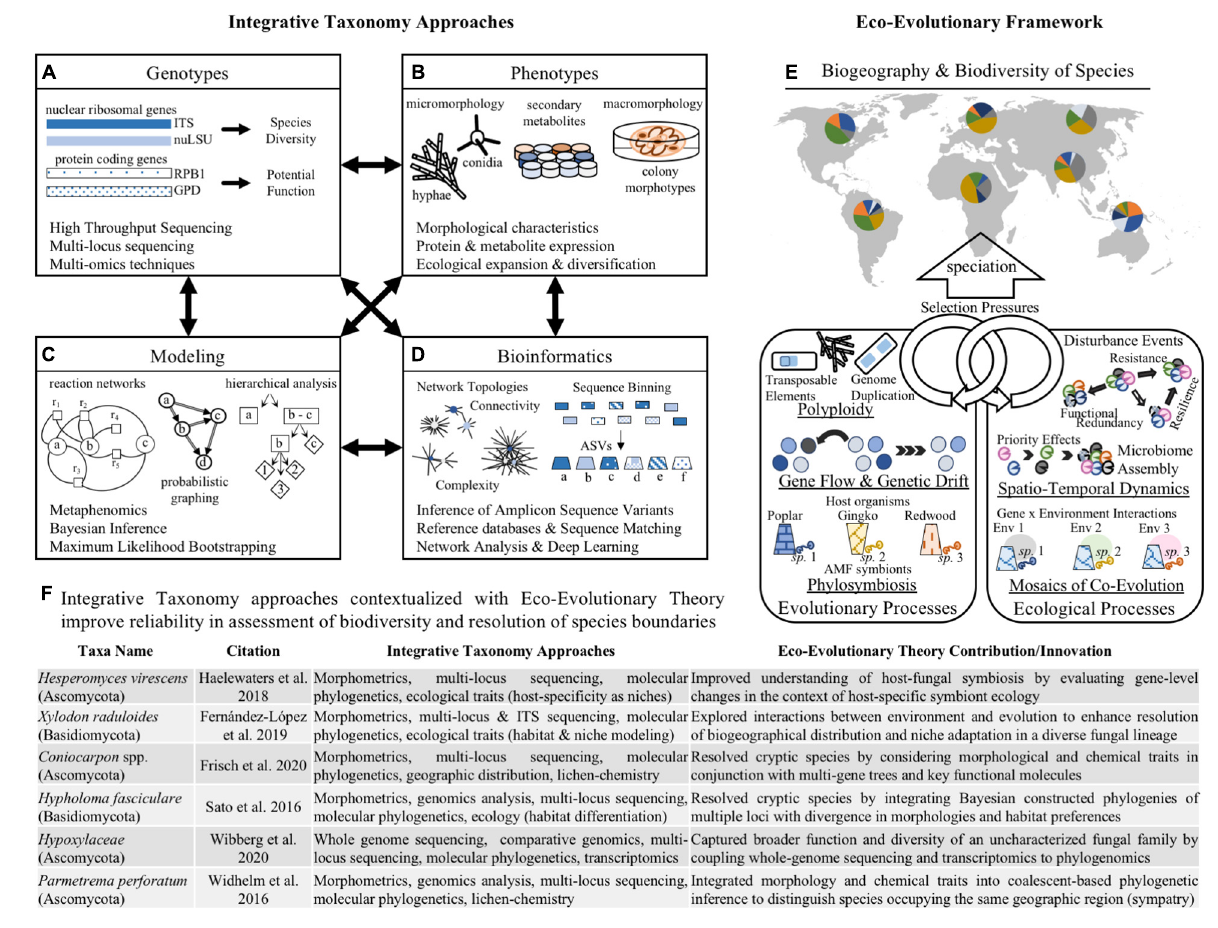
FIGURE 2 | Integrating conceptual frameworks and methodologies for improved fungal species delimitation. The combination of employing integrative taxonomy approaches (A–D) with the conceptual framing of eco-evolutionary theory (E) can lend new insight into (F) prior research and provide a potential scaffold for advancing the study of fungal species. The left side shows various methodological strategies that enable application of the integrative taxonomy framework to resolve species boundaries among fungi. These strategies highlight the relevance of evaluating functional traits of fungal organisms, such as (A) genotype data including high-throughput sequencing of one or more gene regions associated with nuclear DNA or protein-coding regions; and (B) phenotypic information that describes life strategies including morphological characteristics, protein and metabolite expression profiles, and biogeographical distributions for inferring species ranges and boundaries. Further, applying emerging computational and mathematical techniques to functional trait analysis can enhance resolution of species boundaries, such as (C) bioinformatics approaches with improved binning of Amplicon Sequence Variants (ASVs) to more accurately assign taxonomy, and network analysis with improved discrimination of community-level interactions; and (D) modeling approaches that employ statistical foundations to distinguish species using graph theory, reaction networks, and Bayesian inference using priors. The right side highlights the role of eco-evolutionary theory in enhancing resolution of fungal species boundaries. This conceptual approach allows for improved design of research studies and interpretation of experimental results by considering (E) the reciprocal and interacting roles of ecological and evolutionary processes on shaping the diversity and distribution of species. Looking at (F) specific examples of prior research using integrative taxonomy approaches to resolve fungal species boundaries, we can apply eco-evolutionary theory to these findings to provide a scaffold for carrying out and describing future